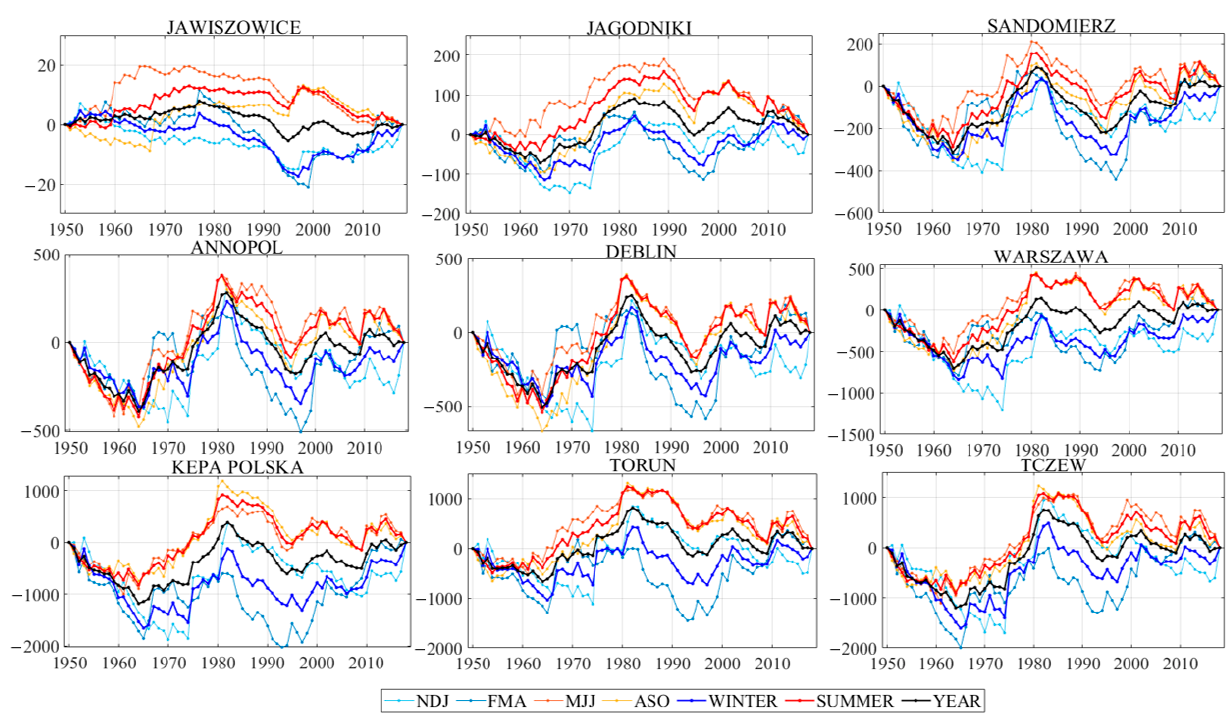
Figure 5. Mass curves of average minimum annual and seasonal flow (MNQ) in the reduced variable coordinates along the course of the Vistula River (values for different seasons: NDJ—MNQ for November–-December–January, FMA—MNQ for February–March–April, MJJ—MNQ for May–June–July, ASO—MNQ for August–September–October, WINTER—MNQ for cold half of the year, SUMMER—MNQ for warm half of the year, YEAR—MNQ for the year). Table 6. The results of testing ( α = 0.05) for trend and change point in seasonal minimum flow (LQ) series in the 1951–2018 period.